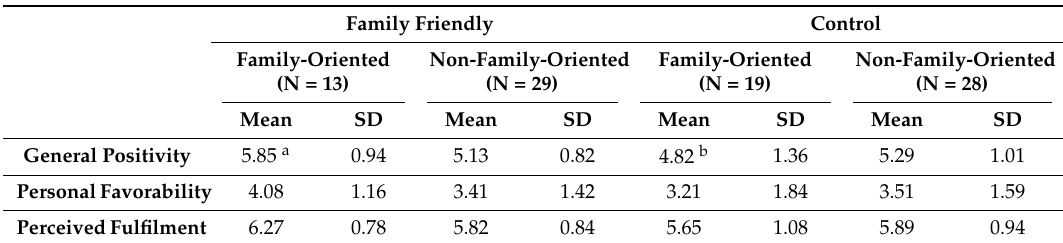
Table 3. Study 2: Means and Standard Deviations by Condition and Family Orientation.